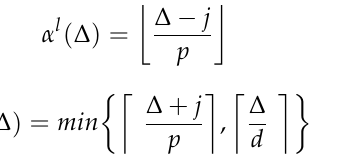
Figure 6. The worst-case latency bound using the network calculus method.